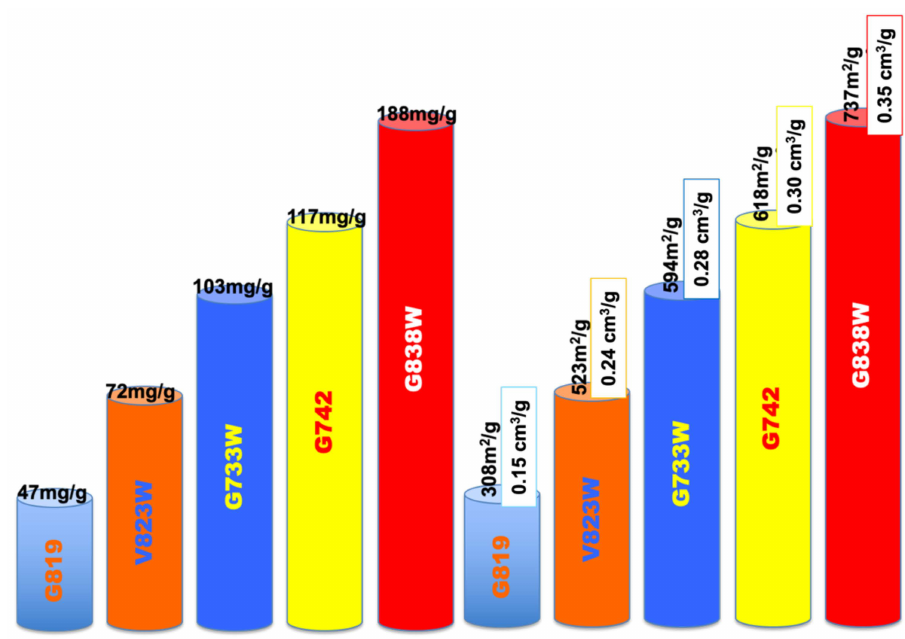
Figure 4. Impact of the porous structure on the phenol